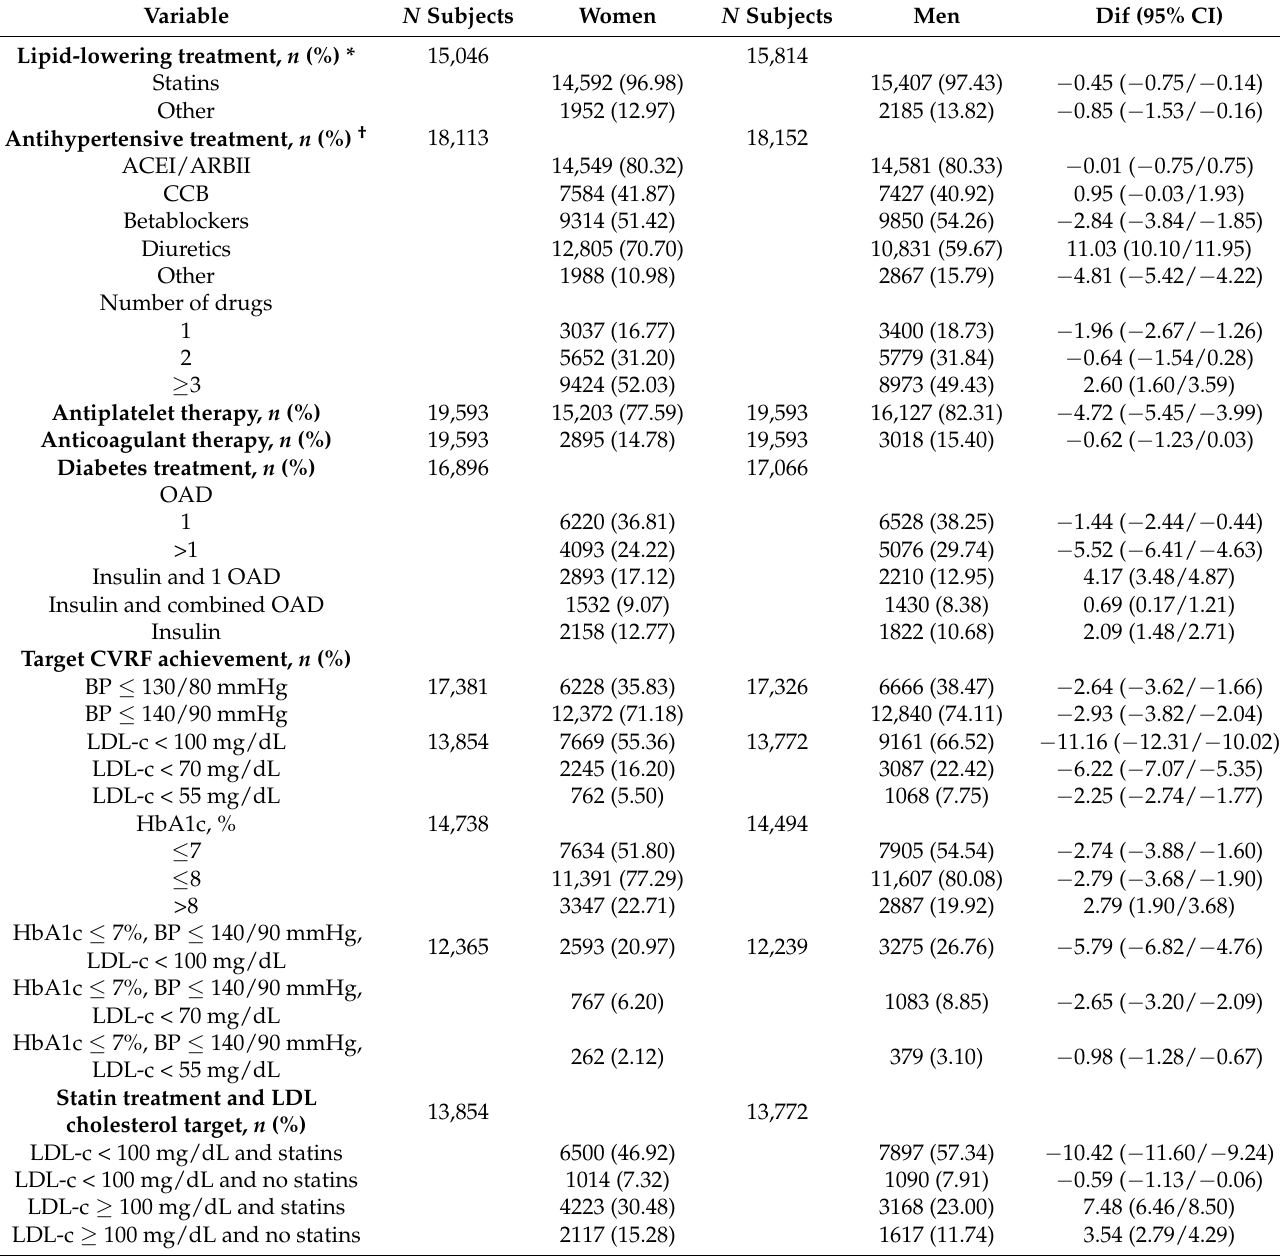
Table 4. Pharmacological treatment and cardiovascular risk factor control of matched women and men with T2DM in secondary prevention by